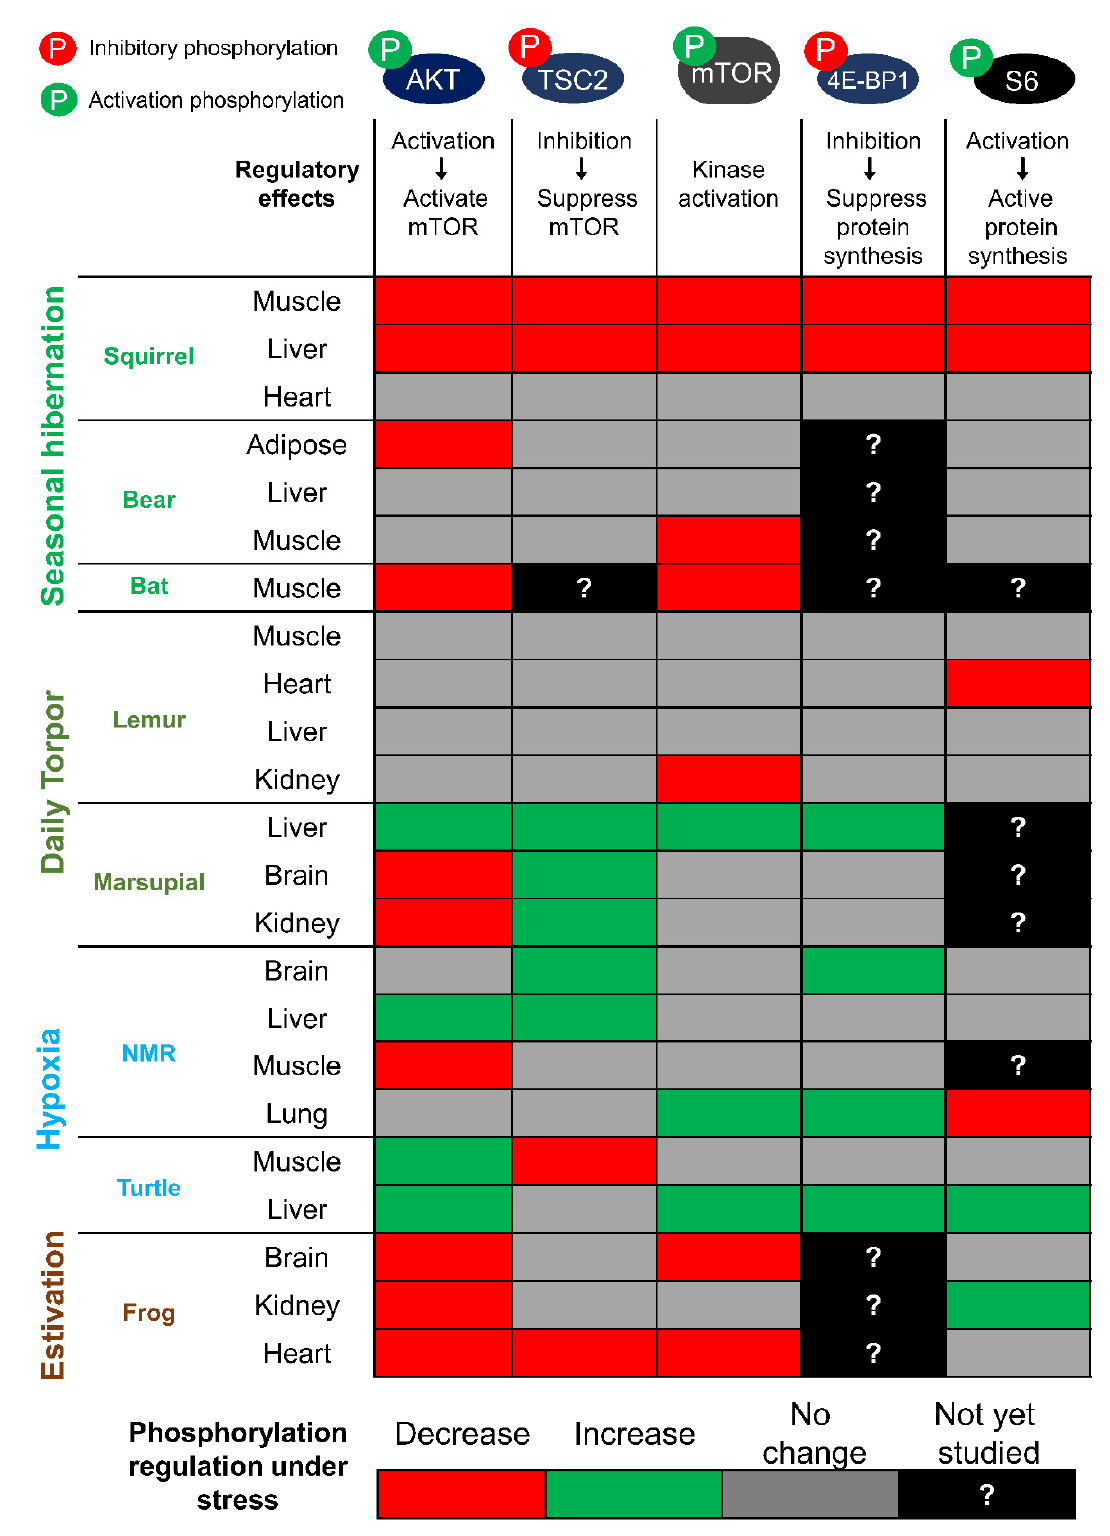
Figure 2. Regulatory pattern of mTORC1 signaling proteins across different animal models of hypometabolic stress. Summary of p-Akt, p-TSC2, p-mTOR, p-4E-BP1, and p-S6 regulation across different animal species under metabolic stress conditions discussed in this review. Phosphorylation (P) in green indicates the activation effect while phosphorylation in red indicates inhibitory effect. Data are summarized from the following studies: [15–19, 46, 51–52].